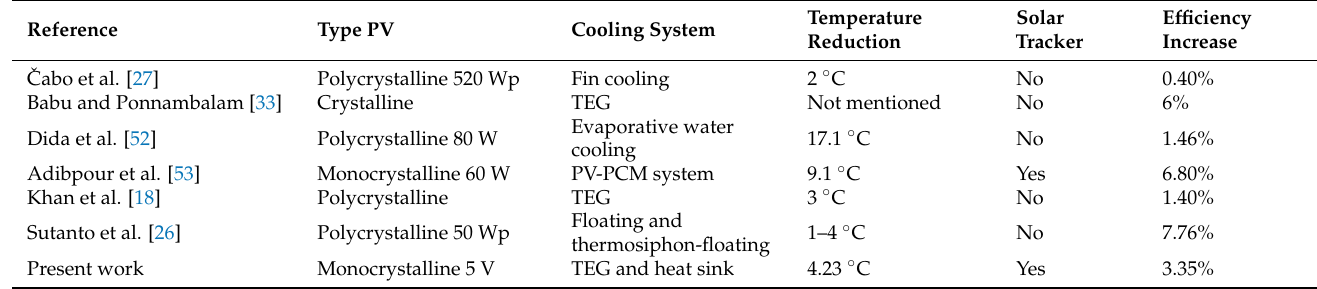
Table 6. Comparison of some cooling systems in photovoltaic